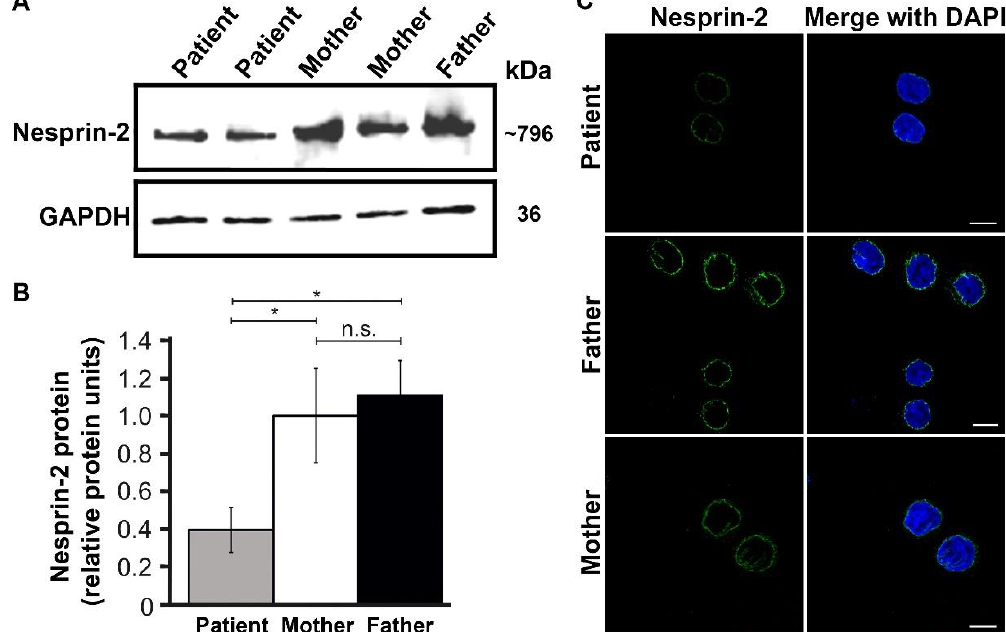
Figure 3. The compound heterozygous SYNE2 mutations p. (Glu788Lys) and p. (Val828Gly), affect the expression of nesprin-2 giant but not the subcellular distribution of nesprin-2 to the nuclear envelope. ( A ) A representative western blot was performed on cell lysates of LCLs from the patient and both parents showing a reduced quantity of nesprin-2 giant protein in the patient (upper panel), GAPDH was used as an internal control (lower panel). ( B ) Comparative quantification of nesprin-2 giant showing a 0.6-fold decrease in the patient (grey bar) as compared to the mother (white bar). Signal intensity was quantified by densitometry. Values are the mean of six independent experiments, error bar represents S.E.M. (standard error mean). Statistical significance was assessed using a one-way ANOVA with Tukey’s post hoc test, * p < 0.05; n.s. = non-significant. ( C ) Confocal microscopy images of LCLs immunolabelled for nesprin-2 (green) of parents (middle and lower panel) and patient (upper panel) showing a marked reduction in the patient. Scale bar 10 µ